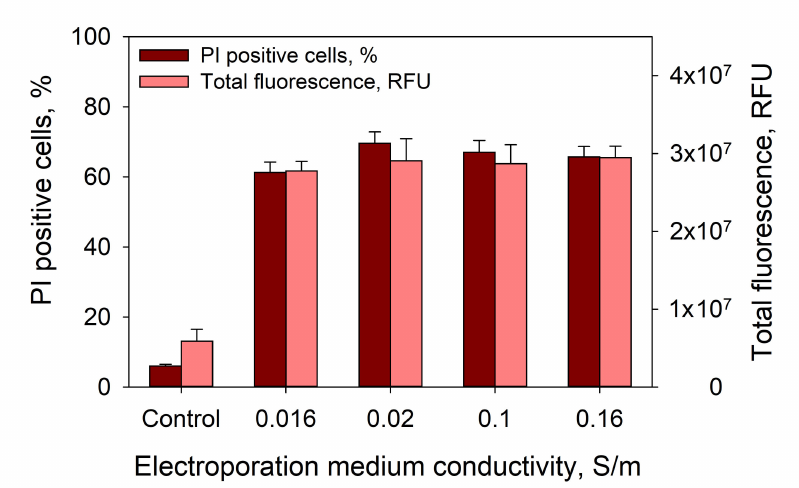
Figure 9. Dependence of PI electrotransfer e ffi ciency and total cell fluorescence of the treated cells on the medium conductivity. Cells were treated with 1 × 1400 V / cm strength and a 100- µ s duration electric pulse. The conductivity of the CaCl 2 -free medium was adjusted by adding MgCl 2 . The control represents untreated cells. PI fluorescence was measured 15 min after the applied electric field. The error bars represent the mean ± standard error of mean of n = 6 experimental replicates.